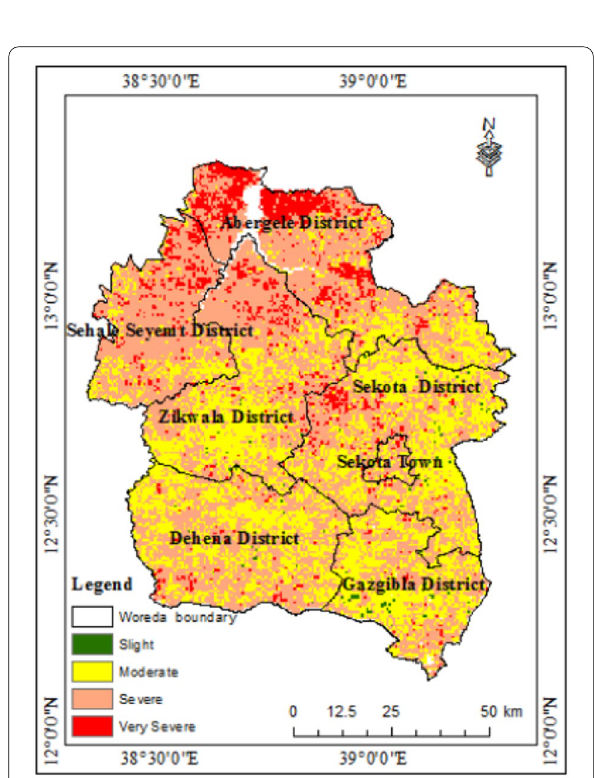
Fig. 18 Combined Drought risk map of study